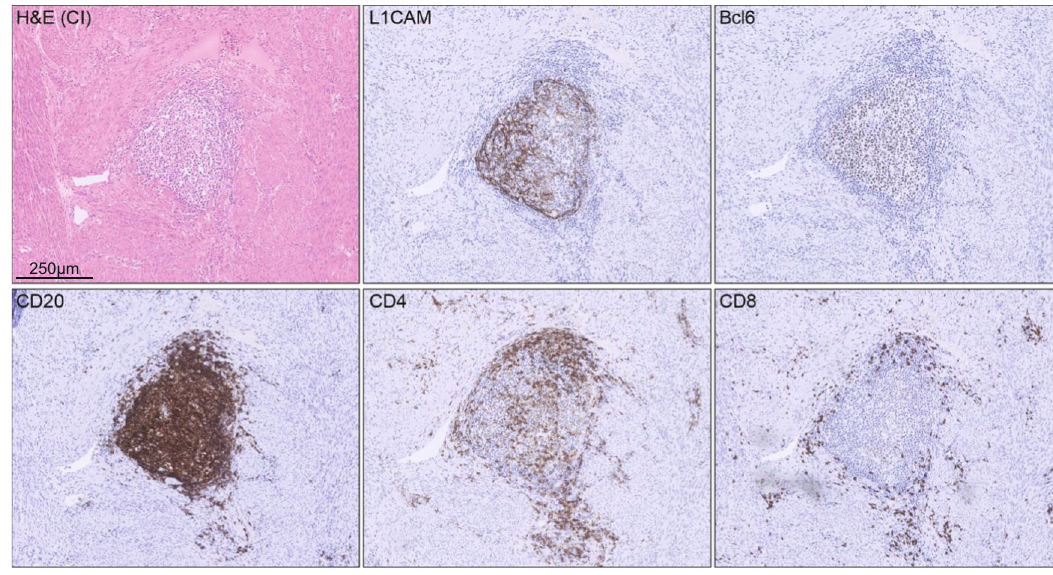
Fig. 3 Hallmarks of mature TLS in L1CAM positive TLS. Representative example of a single endometrial cancer case showing hallmark features of TLS maturation in L1CAM-positive TLS as determined by Bcl6, CD20, CD4 and CD8